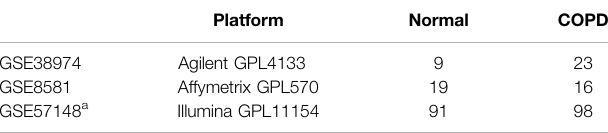
TABLE 1 | Human chronic obstructive pulmonary disease (COPD) data used in this study.